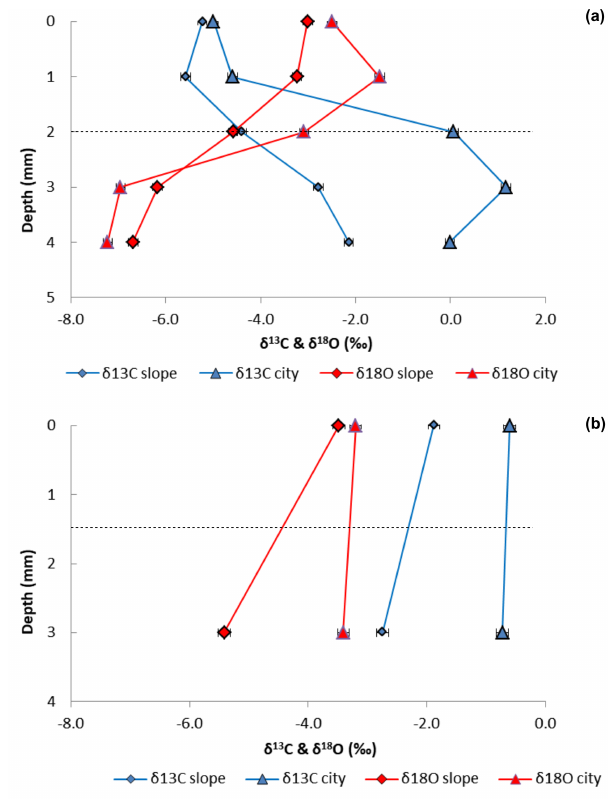
Figure 3. Carbon and oxygen isotopes profiles in BRCs and host rock samples of limestone (a) (Nezer Formation) and chalk (b) (Menuha Formation) samples collected from the Shivta site (trian- gles) and adjacent slopes (diamonds). Dashed lines mark the border between the BRC at the top and the host rock at the